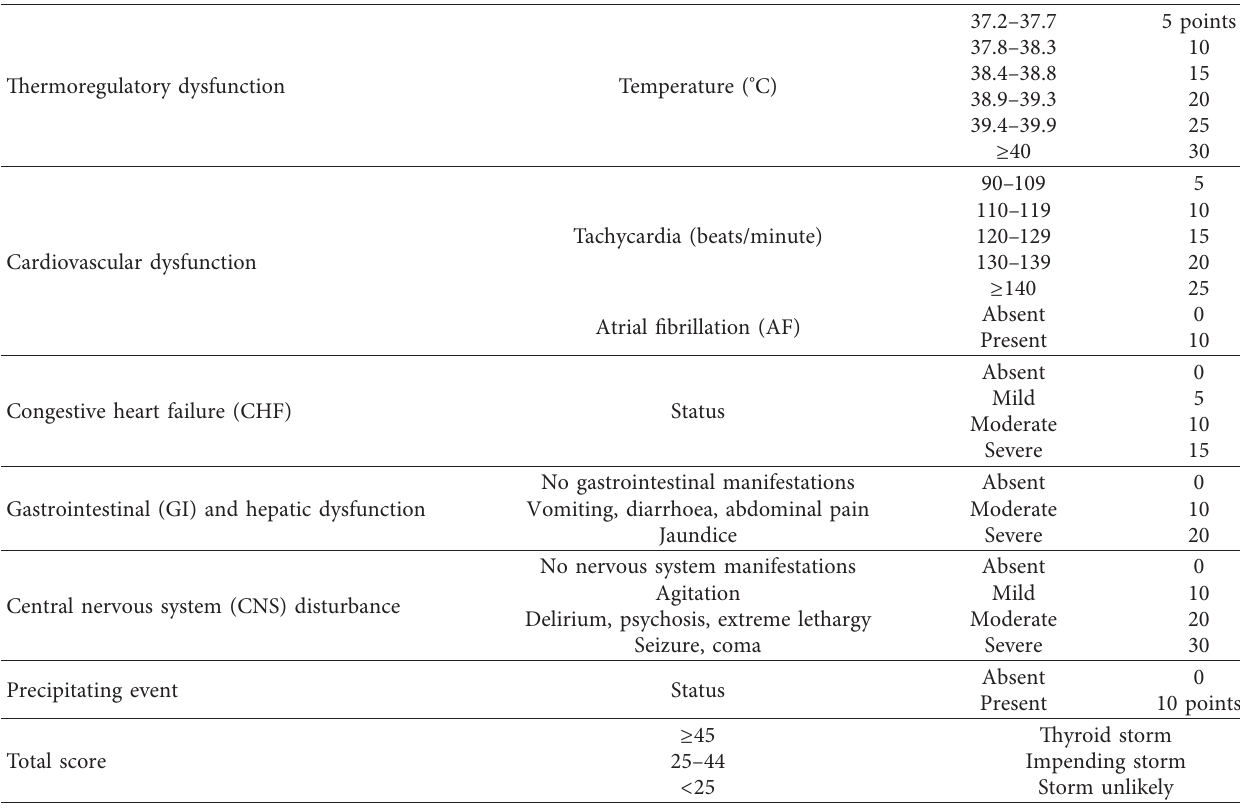
Table 1: The Burch–Wartofsky Point Scale for diagnosis of thyroid storm [5].